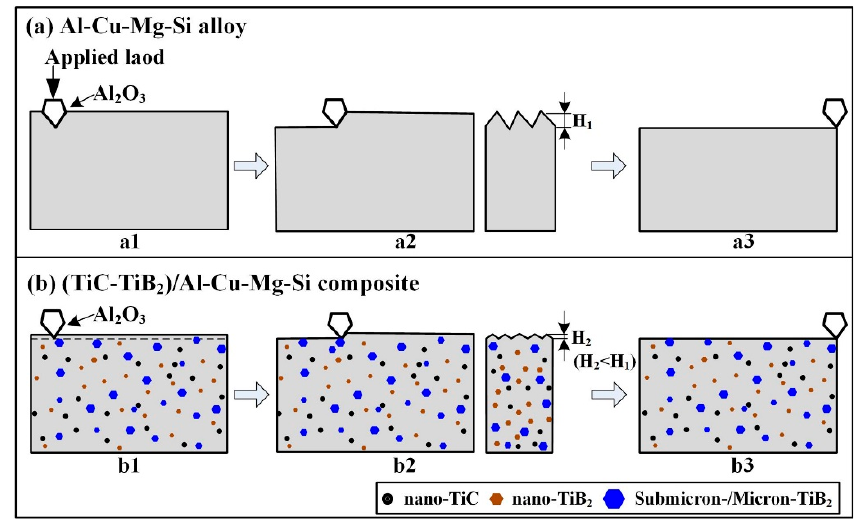
Figure 13. Abrasive-wear behavior schematic view of ( a ) Al-4.7Cu-0.32Mg-0.44Si and ( b ) (TiC- TiB 2 )/Al-4.7Cu-0.32Mg-0.44Si composite.